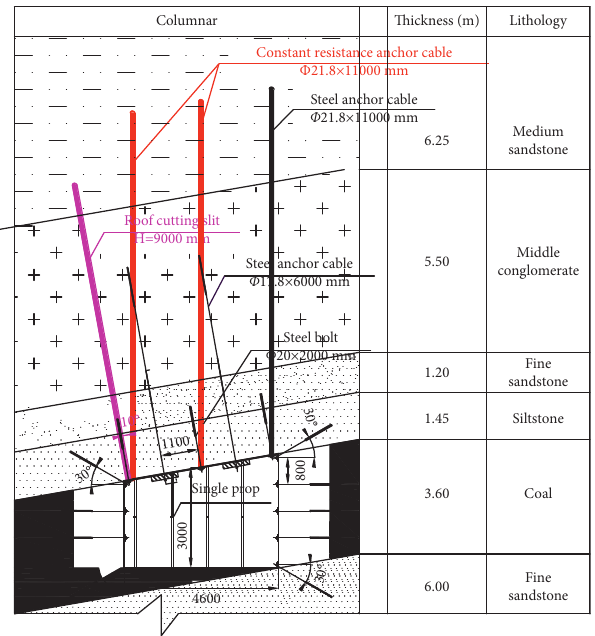
Figure 10: Design of roof cutting and entry supporting in the 43073 working